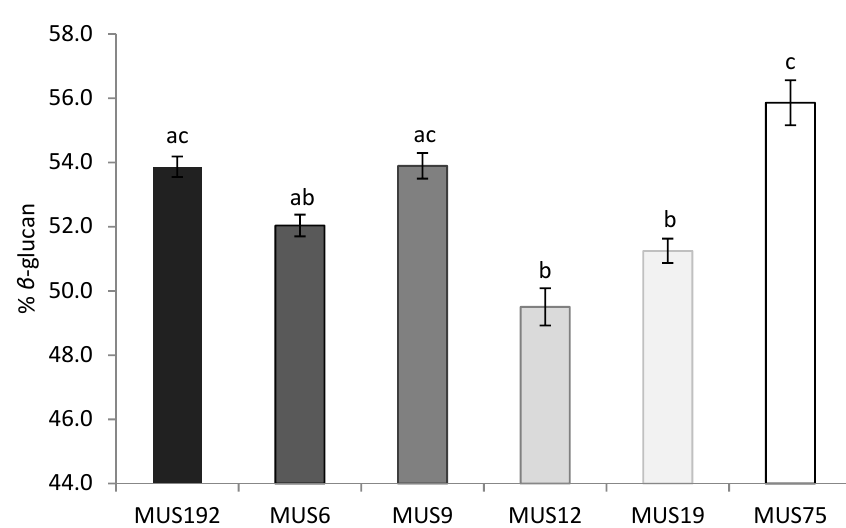
Figure 3. Effect of strain on the β -glucan content of G. lucidum fruiting bodies estimated in Equation (3). Significant differences ( p < 0.05) between the square root yields are represented with different letters (a, b and c).